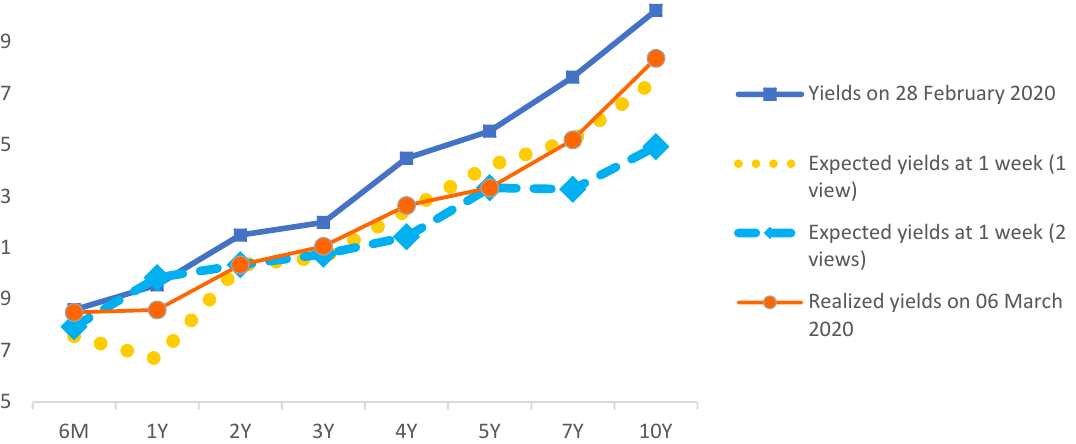
Figure 18. Weekly yield curve forecasts incorporating the trader’s views on 28 February 2020 and realized yields on 06 March 2020. Source: Bloomberg, own computation.